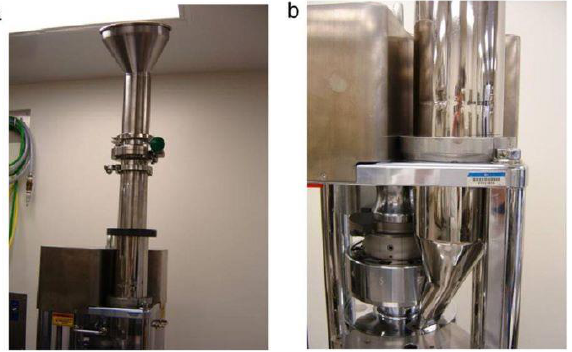
Figure 6. Extended-feeding hopper setup as designed by He et al.: ( a ) overview; ( b ) close up. Adapted with permission from [23]; published by Elsevier,